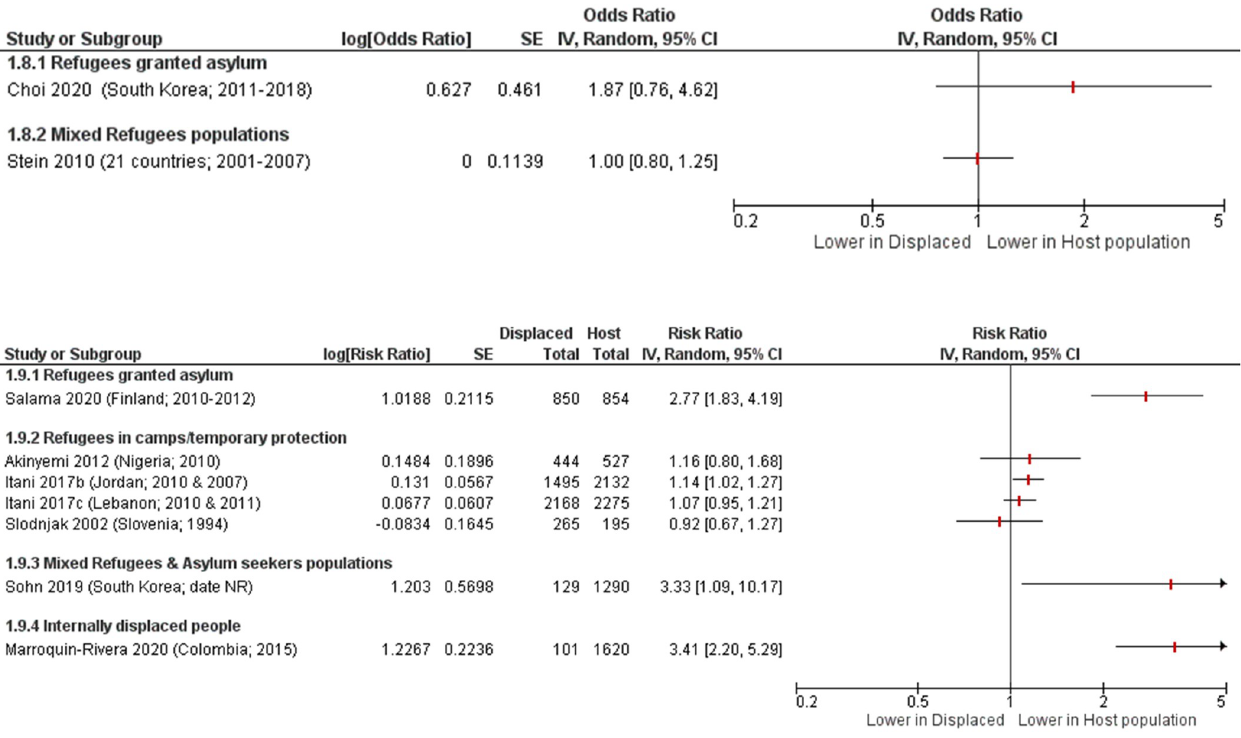
Fig 4. Suicidal ideation in displaced people compared to host population forest plots, grouped by outcome measure and then by population type. Choi 2020 [30] adjusted for interview year; Stein 2010 [81] adjusted for person-year, country, demographic factors (age, sex, time-varying education, time-varying marriage), interactions between life course and demographic variables, parent psychopathology, and childhood adversities; Sohn 2019 [77] age- and gender- matched; Akinyemi 2012 [16], Itani 2017 [45], Slodnjak 2002 [75], Marroquin-Rivera 2020 [54], and Salama 2020 [71] were unadjusted.